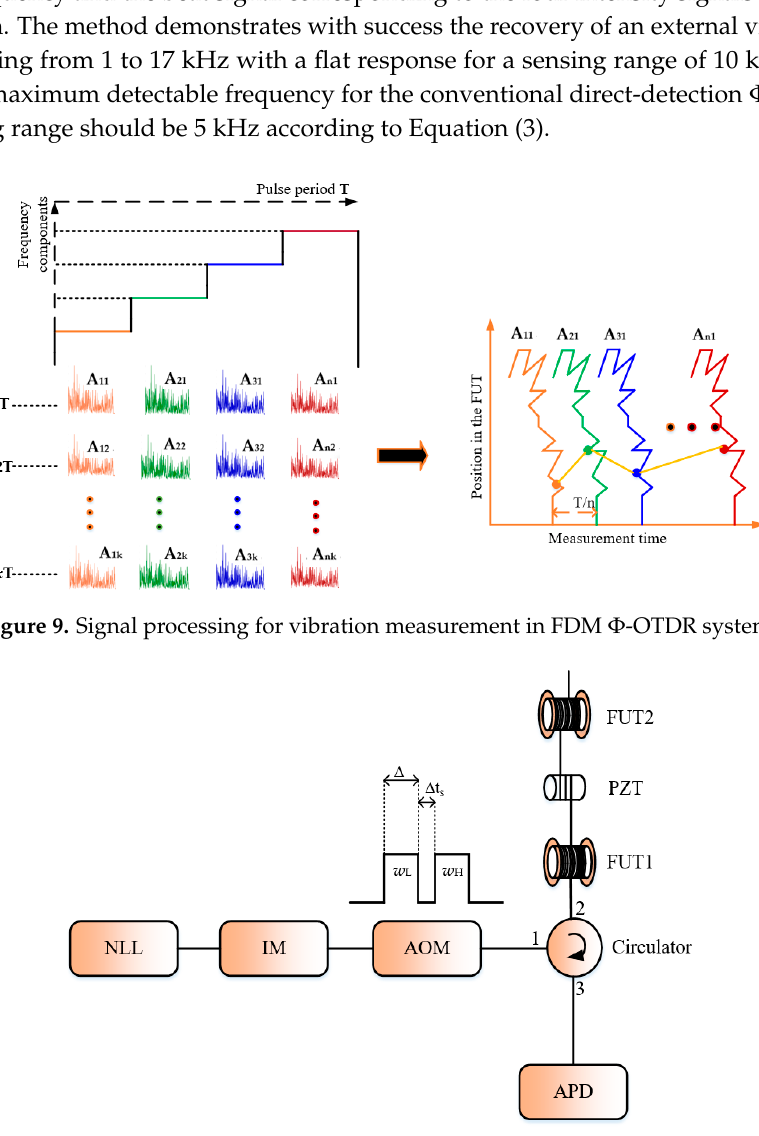
Figure 10. Experimental setup for the implementation of the FDM in direct-detection Φ -OTDR system. w L and w H are the frequency shifts introduced by the AOM in the dual-pulse pairs. ∆ is the pulse-width, ∆ t s is the double pulse spacing time. IM is an intensity modulator and APD is an avalanche photo ‐ detector.